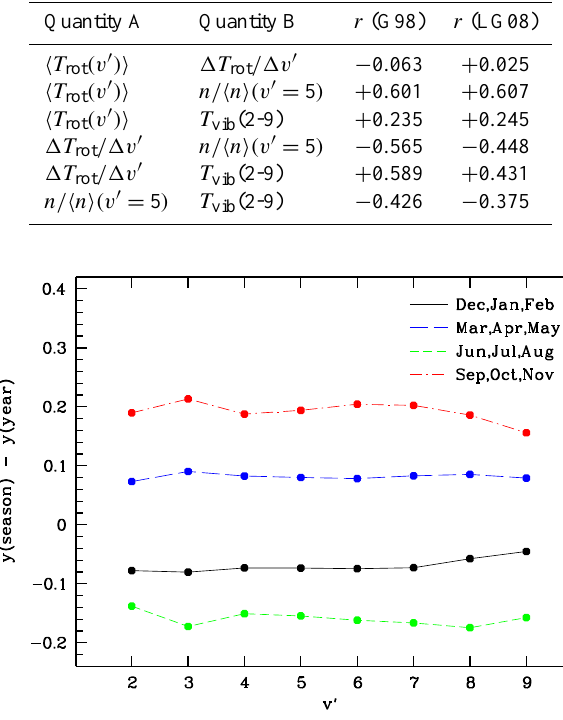
Figure 13. Vibrational population ratio relative to the sample mean as a function of v (cid:48) for different meteorological seasons. The plot details are similar to those of Fig.